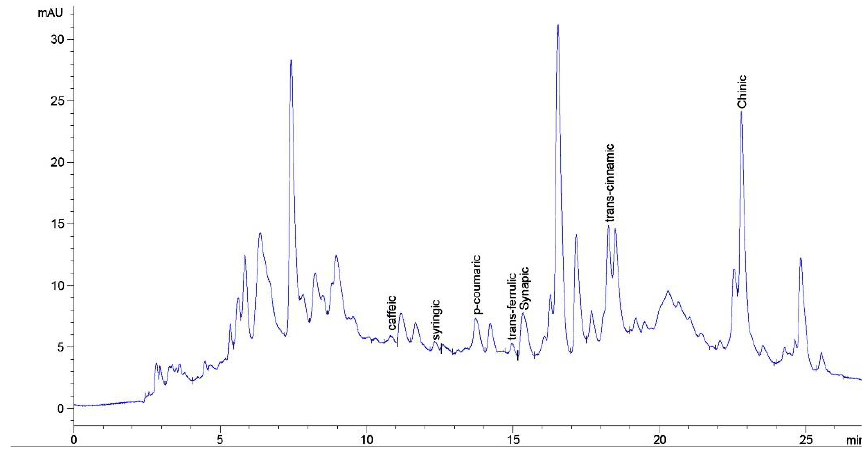
Figure 1. HPLC-chromatogram of hydroxycinnamic acids of the herb extract of A. eupatoria. Caffeic acid and ellagic acid exhibit antioxidant and anti-inflammatory actions. Also, caffeic acid downregulates the inflammatory mediators nitric oxide synthase, COX-2 and TNF- α. p-coumaric acid to inhibit reactive oxygen species production, has antiangiogenic, anti-infective, antioxidant, acts as a free radical scavenger, protects pancreatic islets, pre- vents myocardial and lung injury. Ferulic acid has antibacterial, anti-inflammatory and other effects [9]. Hydroxyphenylacetate and p-coumaric acids predominate in the herb extract of A. eupatoria of the hydroxycinnamic acids. Hydroxyphenylacetate acid has anti- aggregant properties [26]. p-coumaric acid exhibits antioxidant properties, which lead to a decrease in the risk of developing stomach cancer due to a decrease in the formation of carcinogenic nitrosamines. In in vitro experiments, p-coumaric acid showed pronounced anti-inflammatory activity [27]. Also, p-coumaric acid exerts hepatoprotective and hypo- lipidemic effects [28]. As a result of the research 4 flavonoids were determined in the herb extract of A. eupatoria by the HPLC method (Figure 2, Table 3).